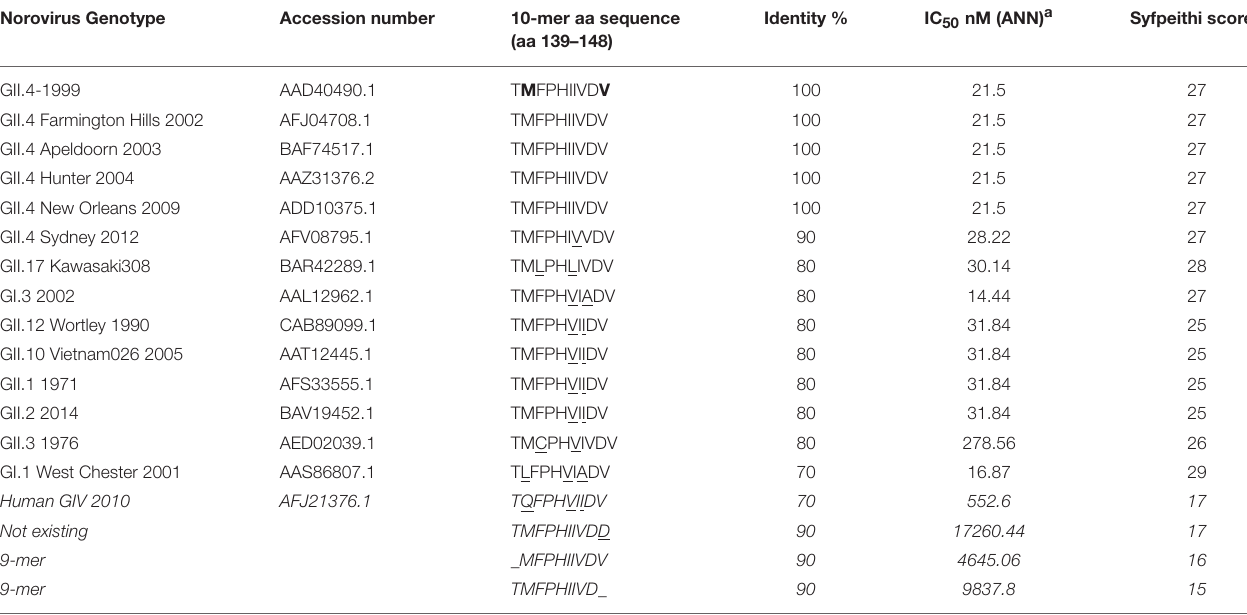
TABLE 1 | Conservation and HLA-A2*0201 allele binding affinity prediction of the norovirus 10-mer epitope. Norovirus Genotype